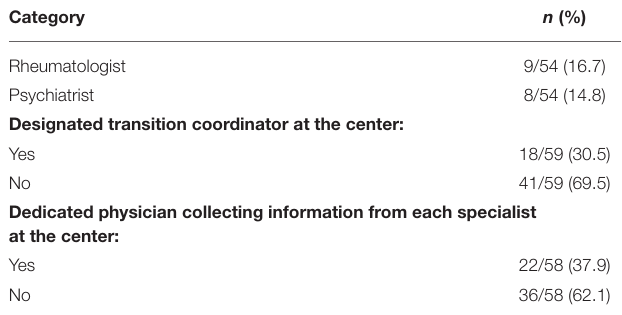
TABLE 2 | Specialties involved in the care of adult IMD patients and their